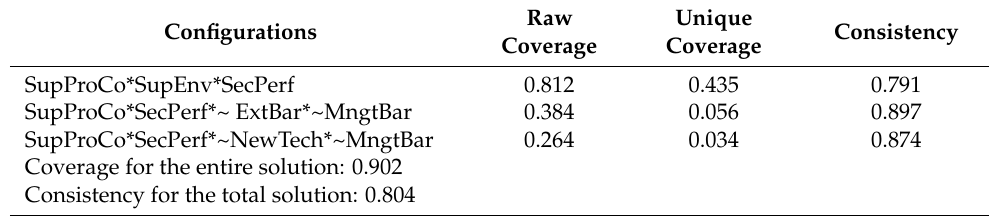
Table 6. fsQCA results: intermediate solution leading to effects of digitalization. Configurations